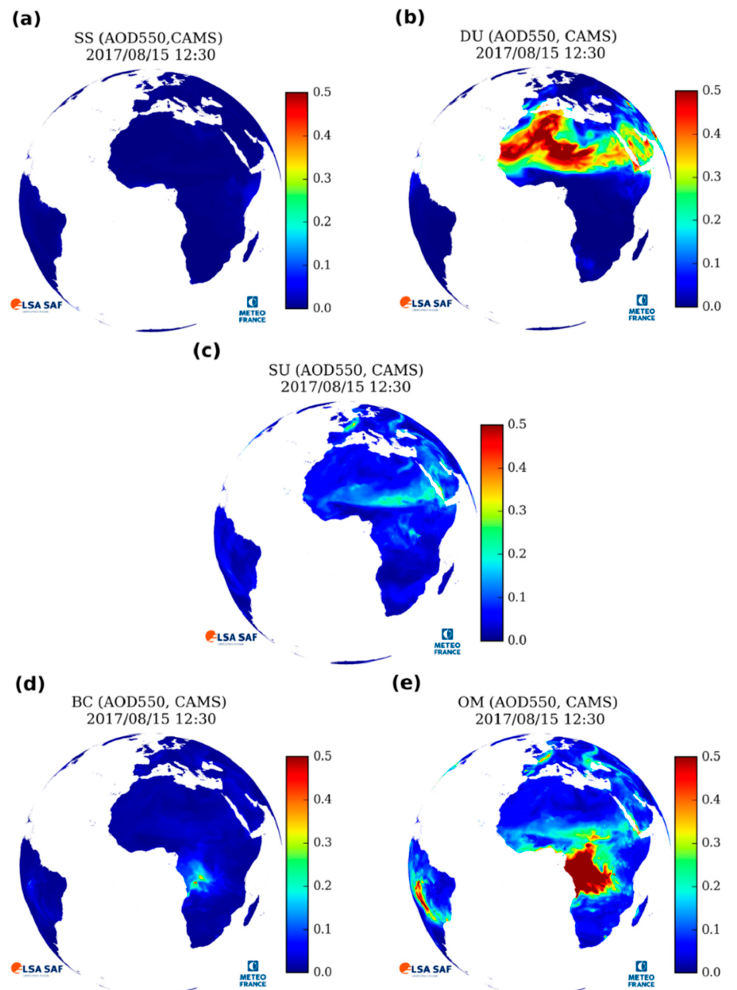
Figure 5. Example of visualization of the CAMS AOD at 550 nm for the 15th of August 2017 at 12:30 UTC for ( a ): Sea Salt aerosols; ( b ): DUst aerosols; ( c ): Sulfate aerosols; ( d ) Black Carbon aerosols; and ( e ) Organic Matter aerosols.